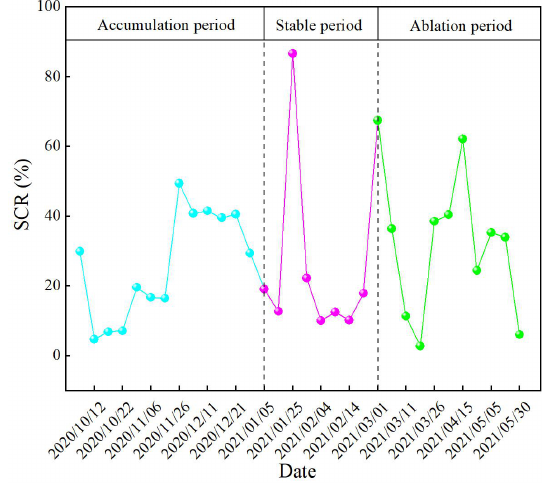
Figure 5. Variation of snow cover ratio during snow cover period in Babaohe River